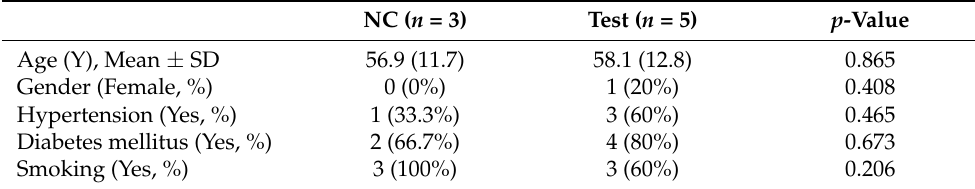
Table 1. Clinical characteristics of